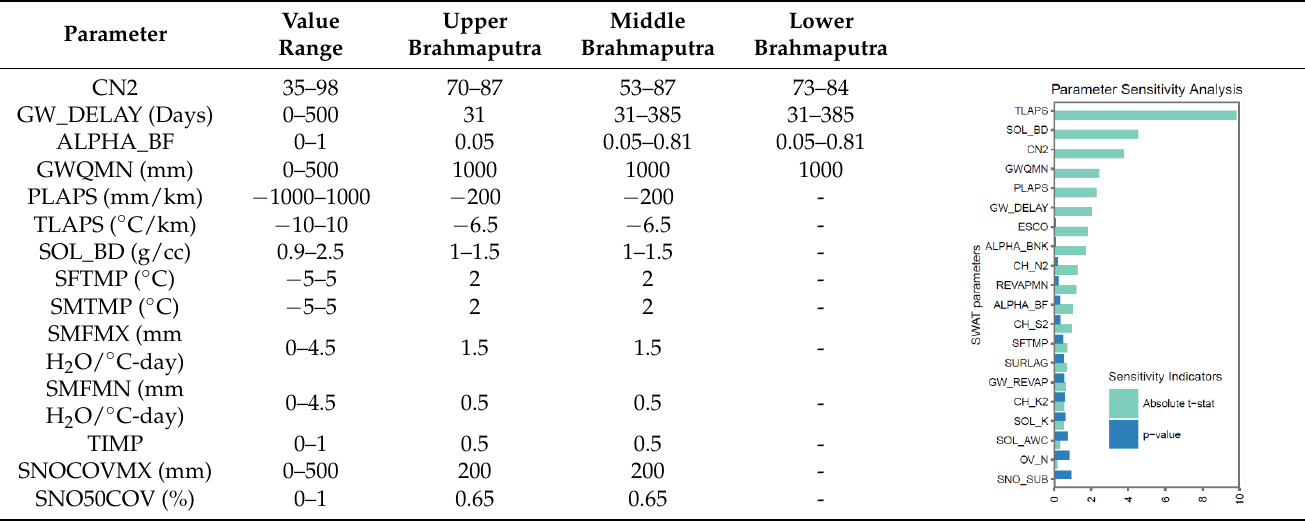
Figure 6. Brahmaputra SWAT model performance at the river points is shown in Figure 2. The blue line represents the observed streamflow, and the red represents the model simulation. Table 4. Calibrated SWAT parameters with their adjusted values. Table 4. Calibrated SWAT parameters with their adjusted values .